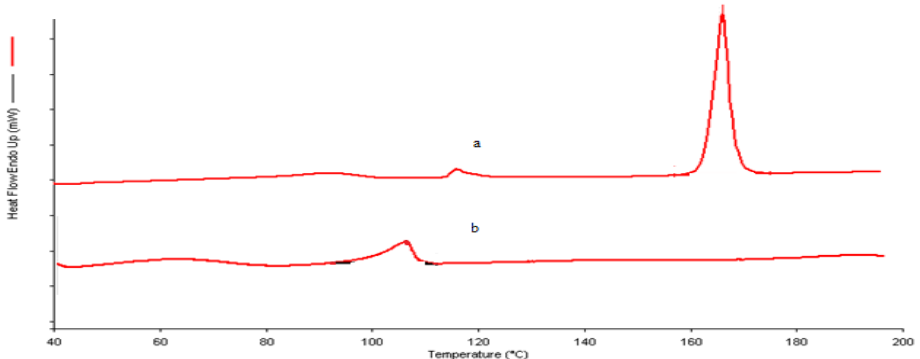
Figure 3. Differential scanning calorimetry (DSC) images of ( a ) MDZ and ( b ) MDZ-loaded CS NPs.